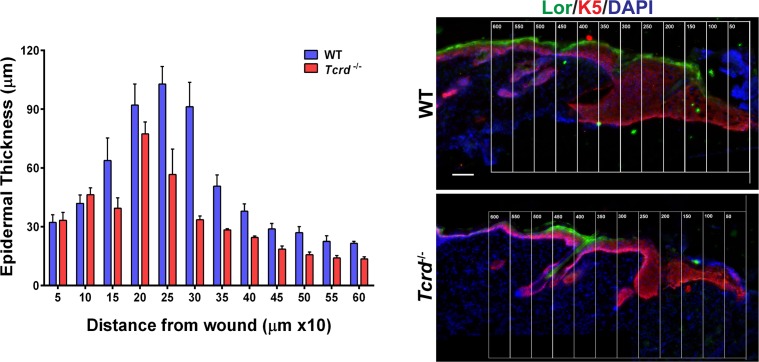
Effect of γδT-cells on epidermal thickness.The epidermal thickness was quantified by measuring the distance between the Keratin-5+ basal layer and the loricrin+ granular layer, starting from the region with keratin-5 expression in the wound of WT and γδT-deficient mice. Each bar in the graph is a mean of three data points obtained from a 50-μm wide region of interest.